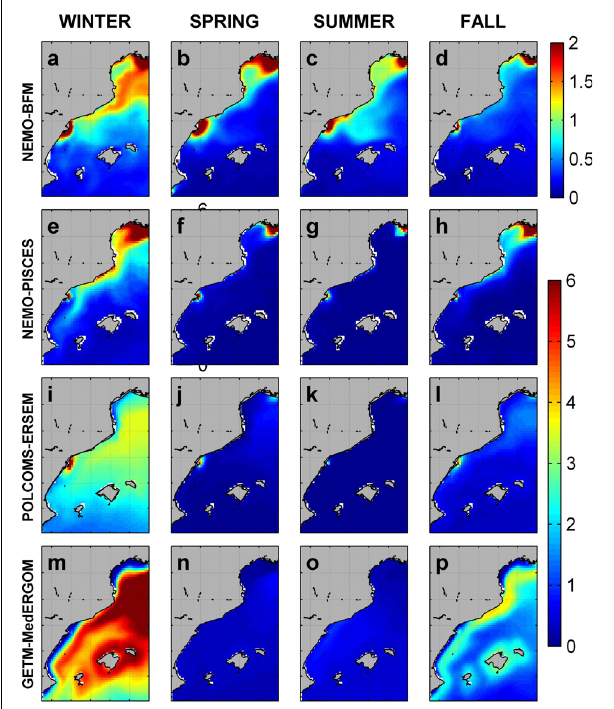
FIGURE 6 | Surface phosphate concentration from each model. Values in µ M. NEMO-BFM (a–d) , NEMO-PISCES (e–h) , POLCOMS-ERSEM (i–l) , and GETM-MedERGOM (m–p)